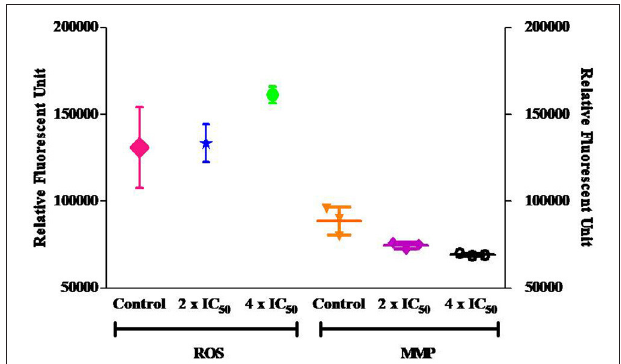
FIGURE 7 | Carvacrol non-significantly increase the reactive oxygen species (ROS) production and decreases the mitochondrial membrane potential (MMP) in FaDu cells. One set of treated FaDu cells was stained with DCFDA dye, and another set was stained with rhodamine 123 dye, followed by analysis via fluorimeter.